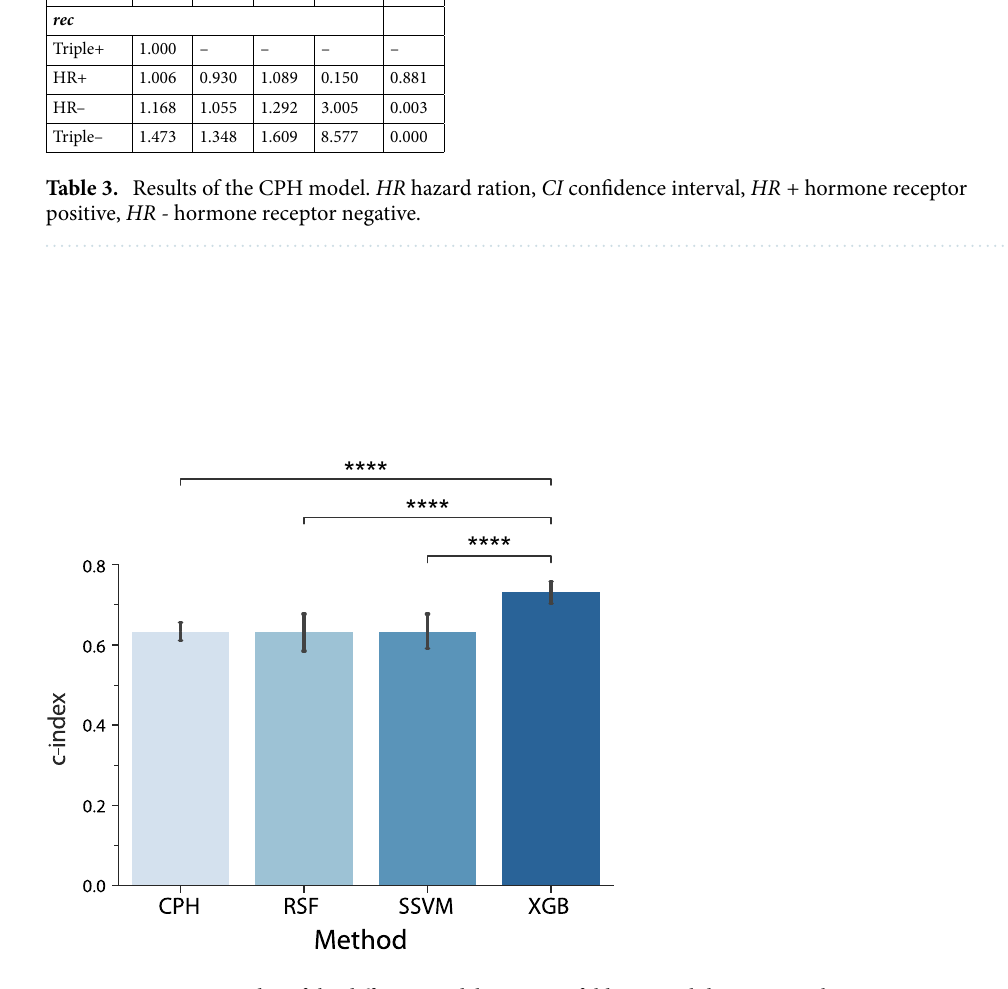
Figure 1. Average c -index of the different models using 10-fold cross-validation. Error bars represent 95% confidence intervals across folds. ∗ ∗ ∗ ∗ p < 0.0001 . All other comparisons were non-significant ( p > 0.05 ) and are not shown for the sake of